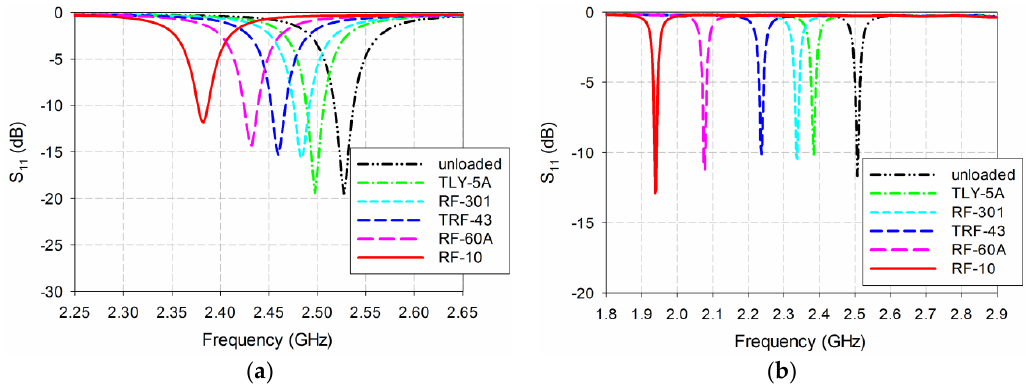
Figure 13. Measured S 11 characteristics of the conventional and proposed patch antennas for the MUTs in Table 2: ( a ) Conventional; ( b ) proposed. Table 4. Measured first resonant frequencies of S 11 responses for the conventional and proposed patch antennas in GHz.